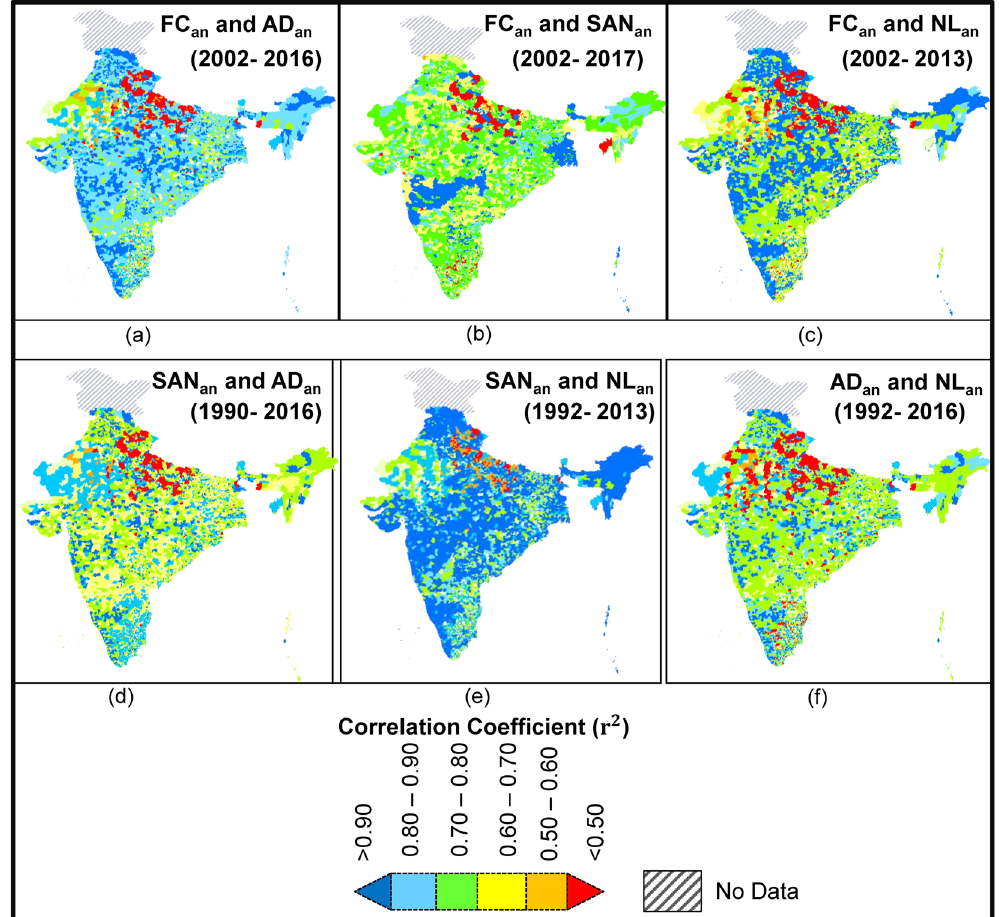
Figure 3. Maps of study area showing correlation for synchronous study periods between different parameters. ( a ) FC an and AD an (2002–2016; r 2 = 0.985 for entire area, A: 0.99, B: 0.91, C: 0.72 and D: 0.522, p < 0.01), ( b ) FC an and SAN an (2002–2017; r 2 = 0.922 for entire, A: 0.96, B: 0.84, C: 0.67 and D: 0.77, p < 0.01), ( c ) FC an and NL an (2002–2013; r 2 = 0.841 for entire, A: 0.96, B: 0.84, C: 0.67 and D: 0.77, p < 0.01), ( d ) SAN an and AD an (1990–2016; r 2 = 0.895 for entire, A: 0.96, B: 0.84, C: 0.67 and D: 0.77, p < 0.01), ( e ) SAN an and NL an (1992– 2013; r 2 = 0.943 for entire, A: 0.96, B: 0.84, C: 0.67 and D: 0.77, p < 0.01) and ( f ) AD an and NL an (1992–2013; r 2 = 0.425 for entire, A: 0.96, B: 0.84, C: 0.67 and D: 0.77, p <